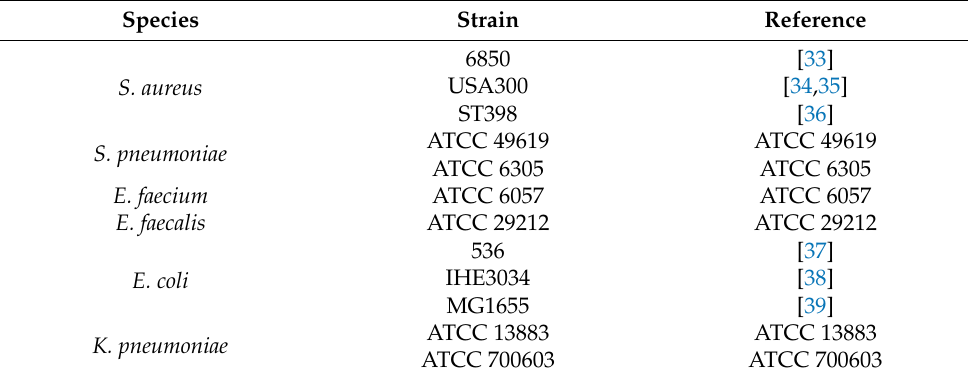
Table 1. Bacterial strains used in this